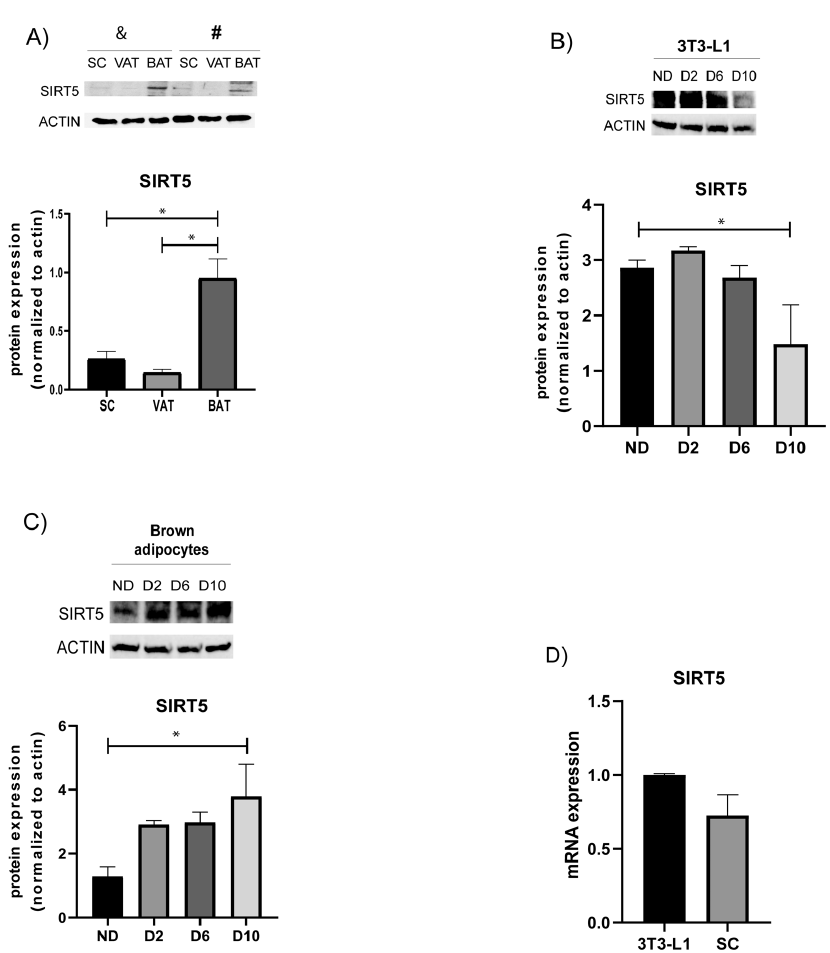
Figure 1. Characterization of SIRT5 expression in mouse fat depots, white and brown adipocytes during in vitro differentiation. ( A ) SIRT5 protein expression in distinct fat depots from male C57BL/6J mice (SC = subcutaneous, (iWAT)); VAT = visceral adipose tissue; BAT = brown adipose tissue). Western blot analysis on two distinct mice (indicated with the symbols & and #) showed higher levels of SIRT5 in BAT compared with those observed in VAT and SC depots. * p < 0.05 vs. BAT. ( B ) SIRT5 protein levels in 3T3-L1 cells, nondifferentiated (ND), at day 2, 6, and day 10 of differentiation, were detected by Western blot analysis. * p < 0.05 vs. D10. ( C ) SIRT5 protein expression during differentiation of mouse primary preadipocytes derived from BAT of male C57BL/6J mice. * p < 0.05 vs. D10. ( D ) Analysis of SIRT5 transcript levels in terminally differentiated 3T3-L1 adipocytes (day 10) and in SC fat depots.